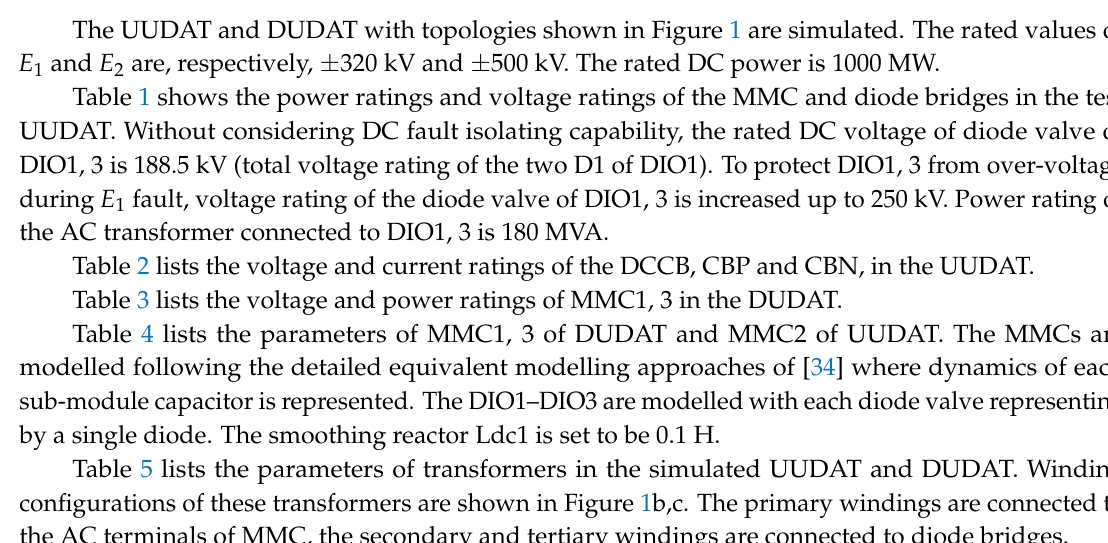
Figure 6. Test system with DUDAT interfacing two MMC converters.